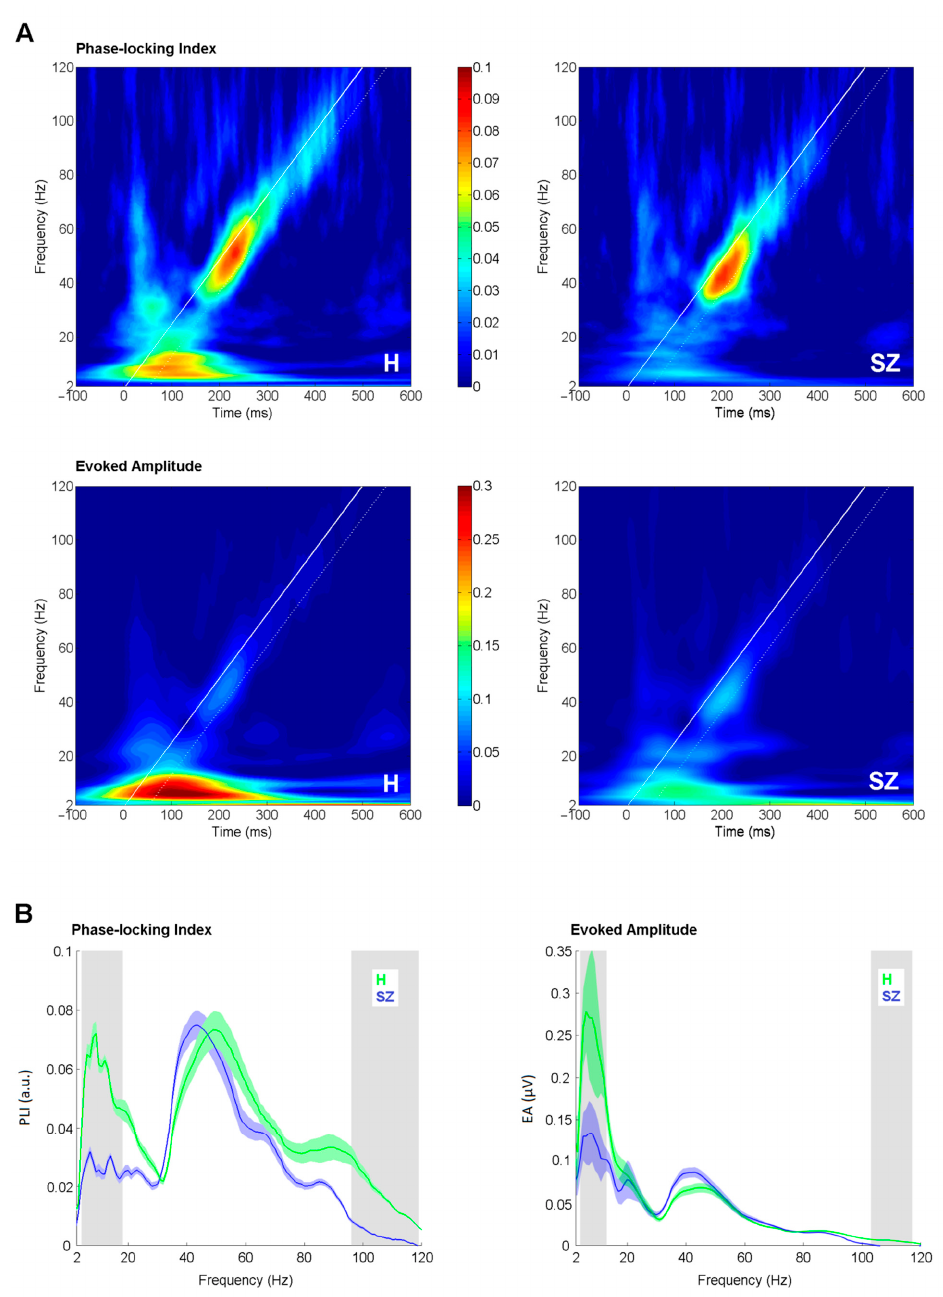
Figure 2. Comparison of envelope following response (EFR) measures between groups. ( A ) Time- frequency plots of phase-locking index (upper panel) and evoked amplitude (lower panel) in healthy controls (H) and schizophrenia patients (SZ) as an average of Fz and Cz electrodes. White bold line corresponds to the stimulation timing; white dashed line denotes +50 ms window of the anal- ysis. ( B ) Phase-locking index and evoked amplitude curves as an average of Fz and Cz electrodes. The shaded color areas around the curve represent standard errors. The significantly different fre- quency windows, as assessed by the bootstrap, are marked by grey shaded areas. Green stands for healthy controls (H); blue stands for schizophrenia patients